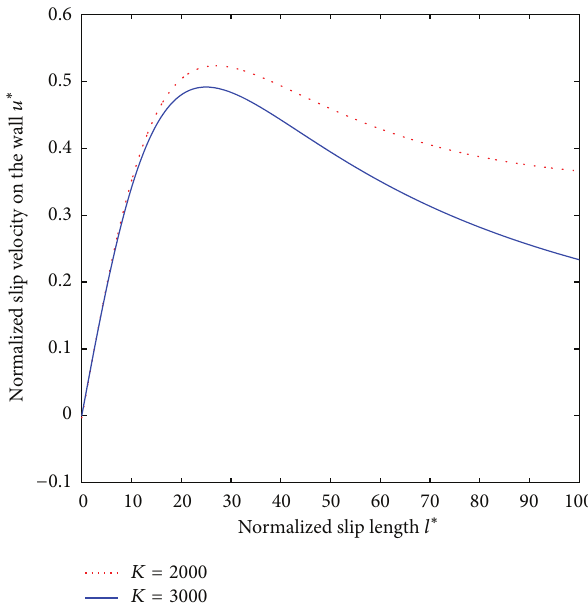
Figure 5: The influence of slip length on the slip velocity on the wall at a typical time 𝑡 ∗ = 𝜃/2𝜋 , obtained with 𝜓 𝑠 𝐸 󸀠 𝑧 /𝑎 1 = 10 −3 , 𝑙 ∗ = 1 . effect of slip length on the velocity on the wall at a typical time step 𝑡 ∗ = 𝜃/2𝜋 , obtained with 𝜓 𝑠 𝐸 󸀠 𝑧 /𝑎 1 = 10 −6 , 𝐾 = 3000